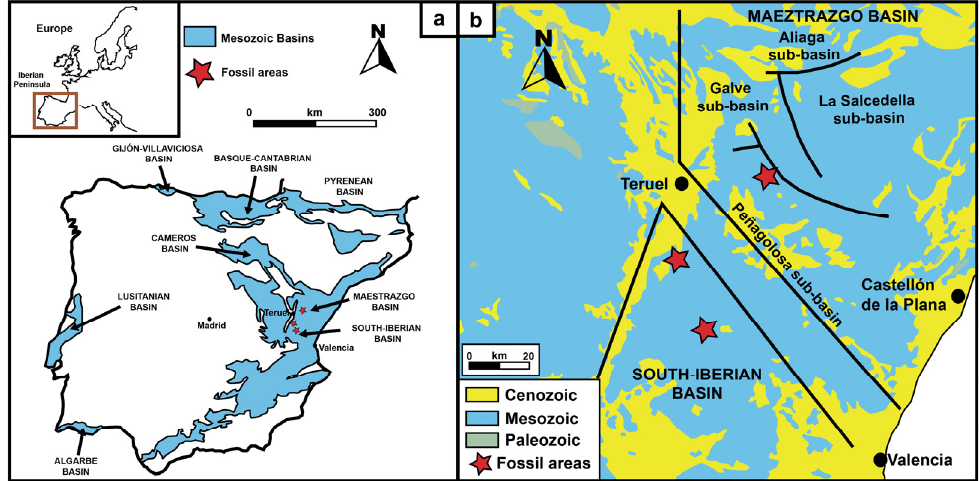
Figure 1. ( a ) Location of the fossil areas studied. ( b ) Geological map of the studied region that shows the limits of the basins and the more detailed location of the fossils areas. Cartography modified from [40].